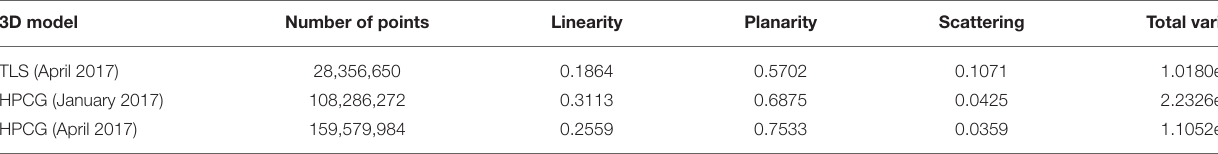
TABLE 3 | Point cloud quality analysis for Bay #5 using mean values of dimensionality features.